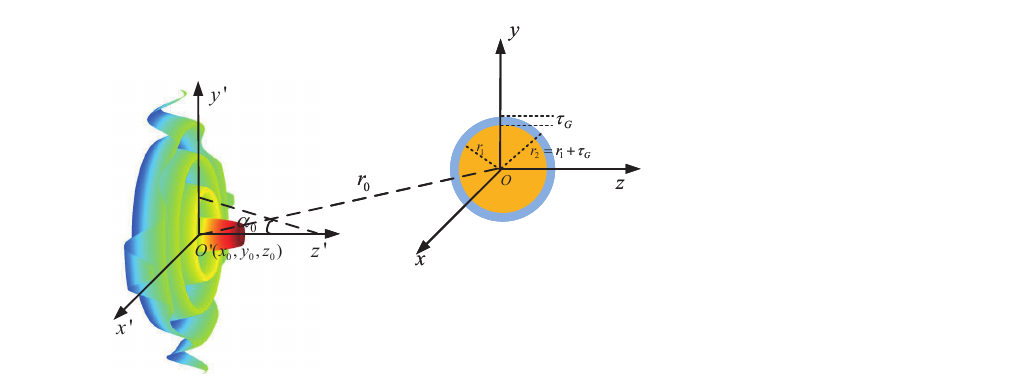
Figure 1. Geometry of a graphene-coated gold nanosphere illuminated by a vector Bessel